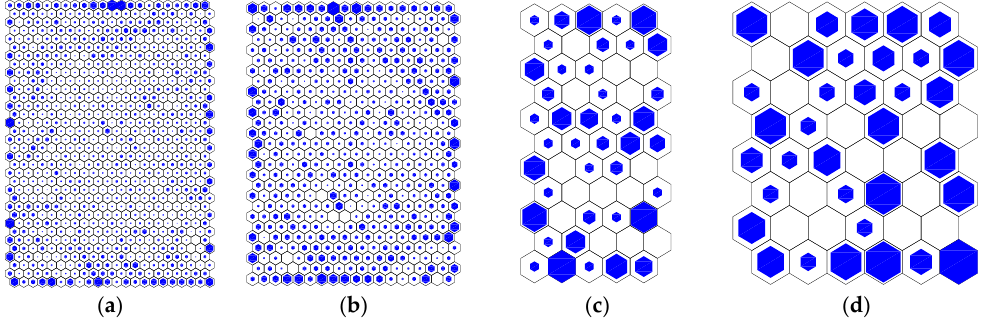
Figure 5. Map of number of hits ( a ) Dutch full dataset; ( b ) Dutch WTW Andijk dataset; ( c ) UK customer taps dataset; ( d ) UK small looped network dataset.